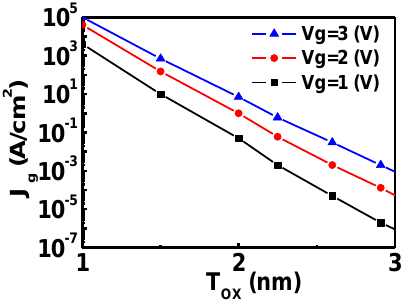
Figure 1. Gate tunneling current as a function of oxide thickness for various gate biases. In this example, the gate tunneling current is dominated by election tunneling from the conduction band of the vertical NMOS diode of an NMOSFET